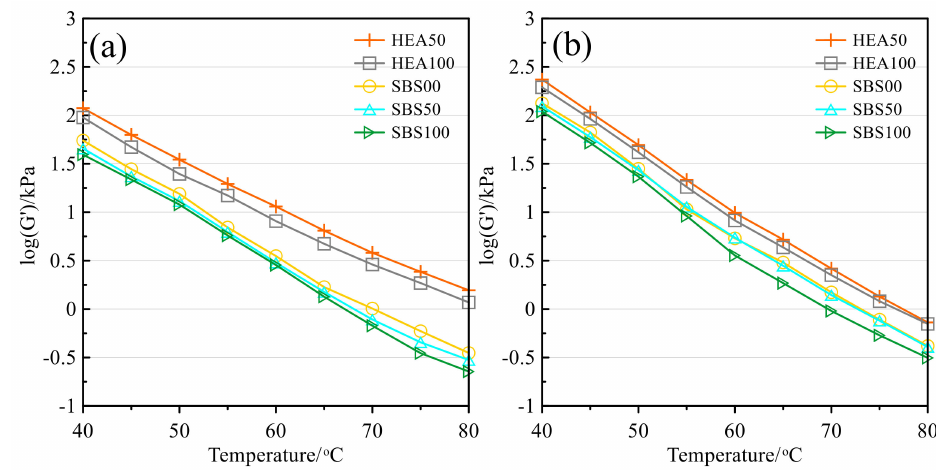
Figure 4. Storage modulus: ( a ) Before TFOT; ( b ) After TFOT.